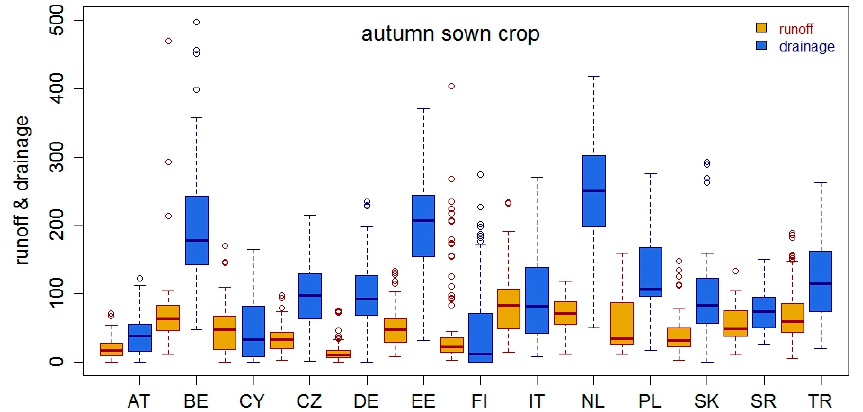
Figure 5. Runoff (mm) and drainage (mm) during the growing season of autumn sown crops across the European regions for the period 1992–2012. A two letter code refers to the country that the region belongs to.